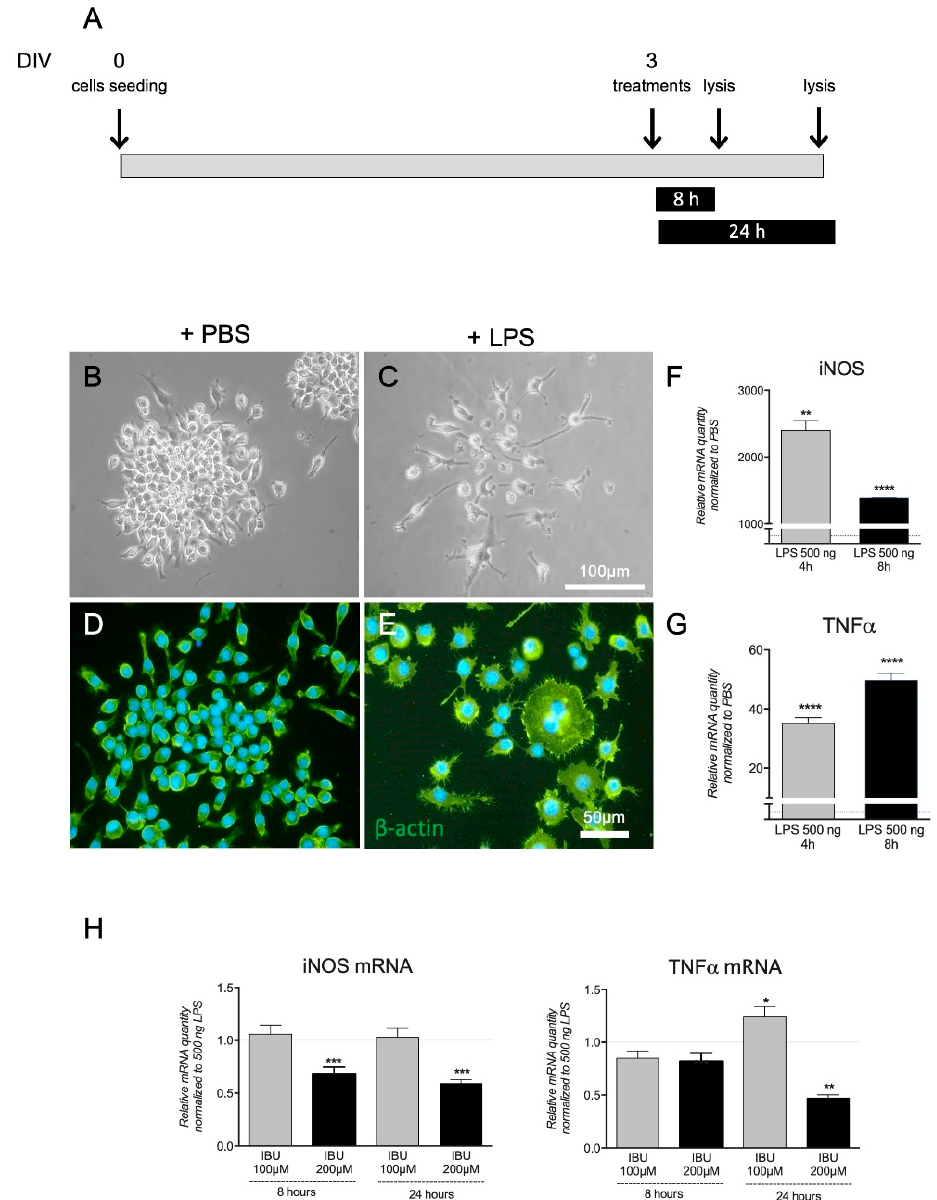
Figure 1. Effect of Ibu exposure on LPS-induced molecular regulations in macrophages. ( A ). Schematic representation of the experiment timeline. Morphological evaluation of RAW 264.7 cells exposed to PBS ( B , D ) or LPS ( C , E ). Image includes pictures in bright field ( B , C ) and in epifluorescence microscopy by b-actin immunostaining ( D , E ). The graphs report the expression level of iNOS ( F ) and TNF- α ( G ) mRNA, expressed as a variation (fold of increase) with respect to PBS-treated culture, indicated by the white horizontal bar. The graphs report the effect of soluble Ibu at two different concentrations and two different post-exposure times on iNOS and TNF- α mRNA expression ( H ). Statistical analysis: Student’s t -test, * p < 0.05, ** p < 0.01, *** p < 0.001, **** p <